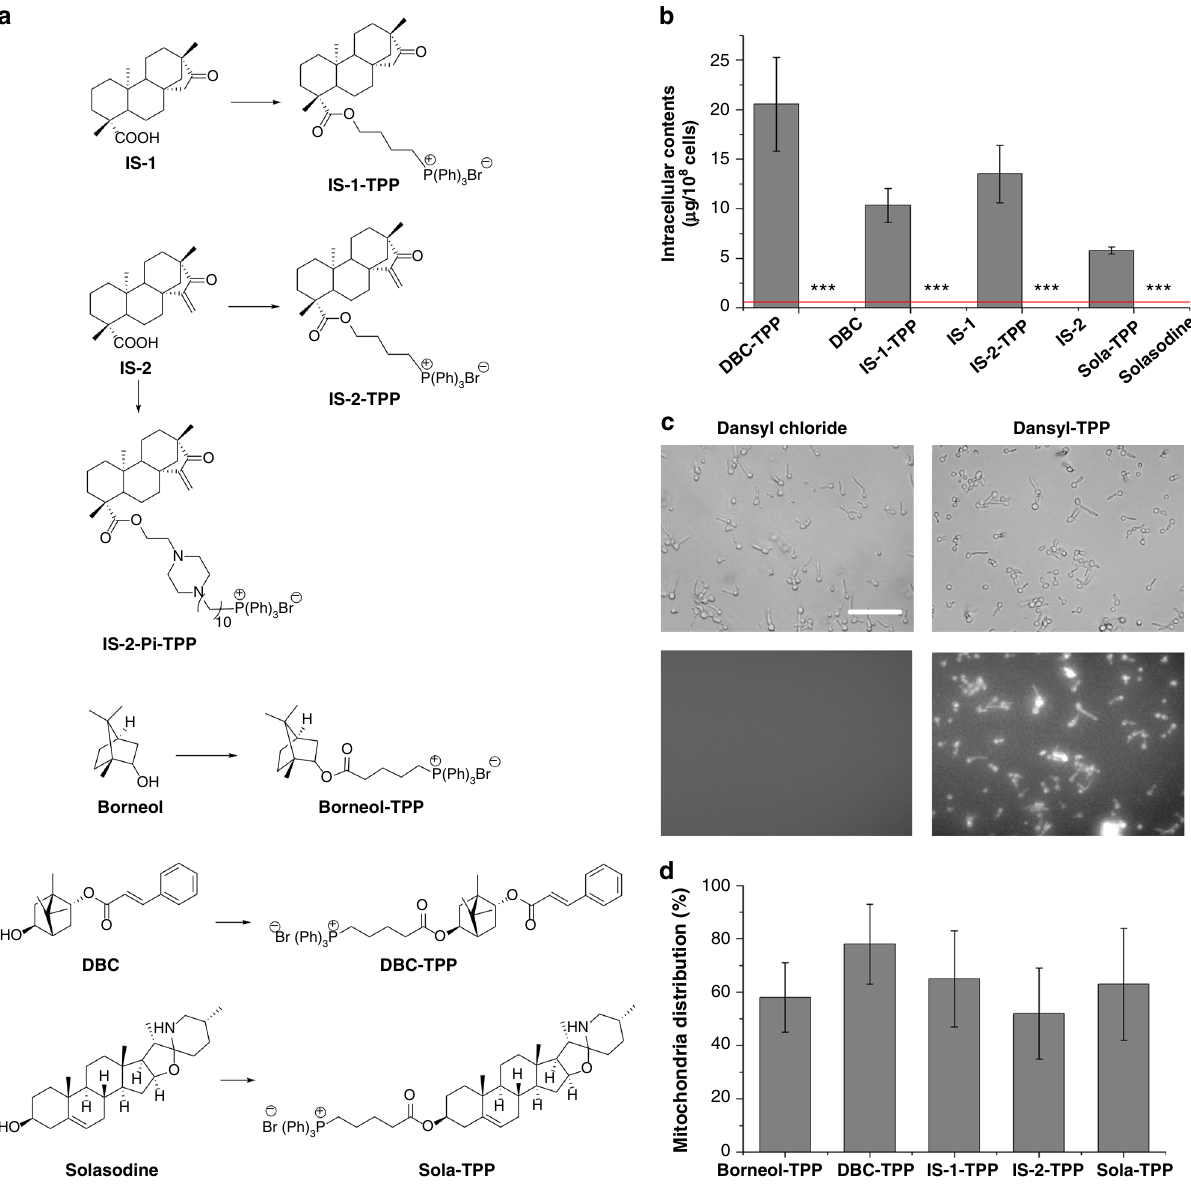
Fig. 2 TPP + targets PEPSs to the mitochondria of C. albicans cells. a The chemical structures of representative TPP + -conjugates and their parent compounds. b The intracellular contents of TPP + -conjugates and their parent compounds in the treated C. albicans cells were measured using HPLC. The detection threshold using HPLC was 0.1 μ g for DBC and 0.4 μ g for the other three parent compounds that was indicated by a red line. The HPLC analysis results demonstrated that these TPP + -conjugates accumulated in C. albicans cells, whereas their parent compounds were not transported into cells. Data are shown as means ± s.e.m. from three independent experiments. *** P < 0.001 for TPP + -conjugates versus their parent compounds by Student ’ s t -test. c Fluorescence microscopy revealed that Ds-TPP accumulated in C. albicans cells cultured in RPMI1640 medium, whereas its parent compound dansyl chloride did not. Scale bar, 100 μ m. d The accumulation of the representative tested compounds in C. albicans mitochondria. The contents of the tested compounds in the mitochondria and other intracellular components were determined by LC – MS/MS, and the ratio of the tested compounds in the mitochondria was calculated. Data are shown as means ± s.e.m. from three independent